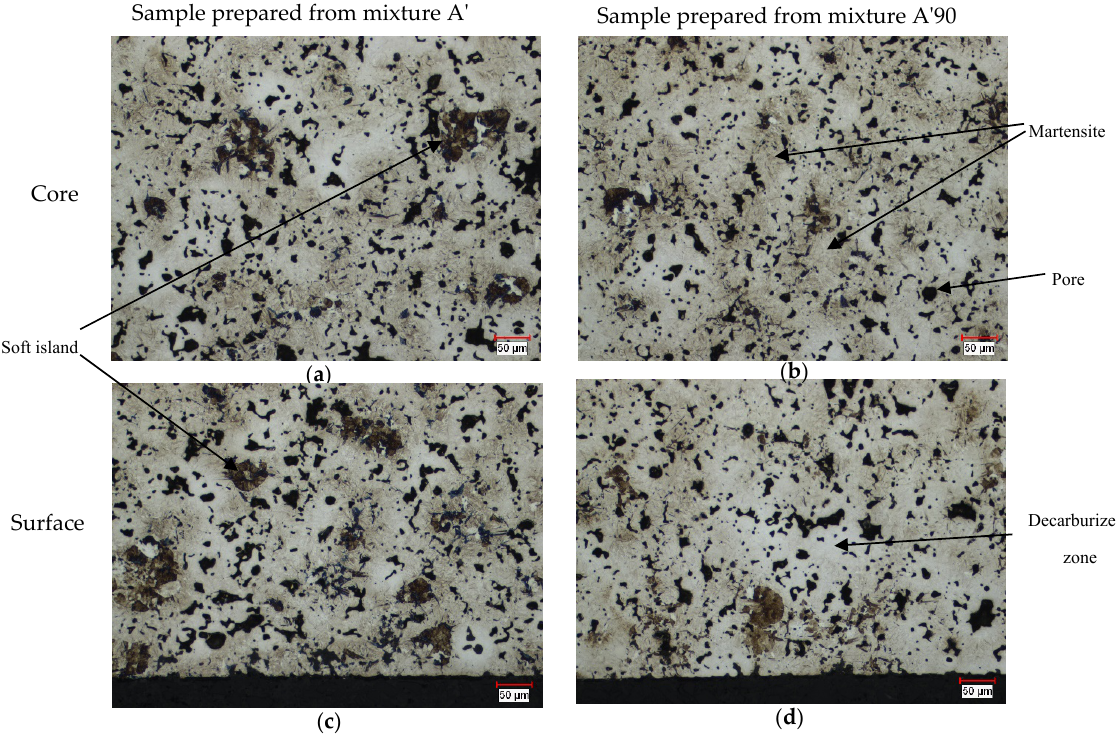
Figure 13. Optical images for sintered and heat treated bars prepared from powder mixtures A’ and A’90 using magnification 200×, images ( a ) and ( c ) are for a sample prepared from mixture A' at core and surface, images ( b ) and ( d ) are for a sample prepared from mixture A'90 at core and surface respectively.